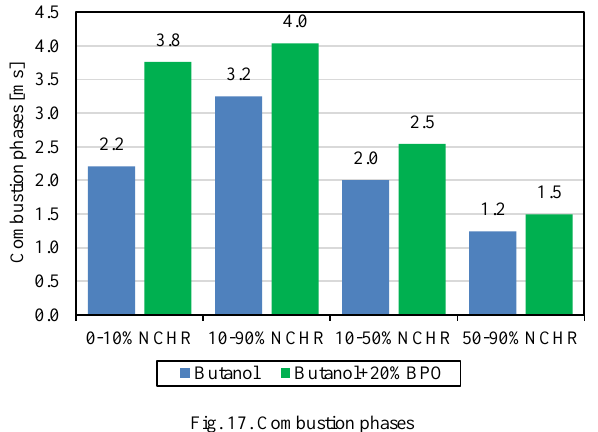
Fig. 17. Combustion phases